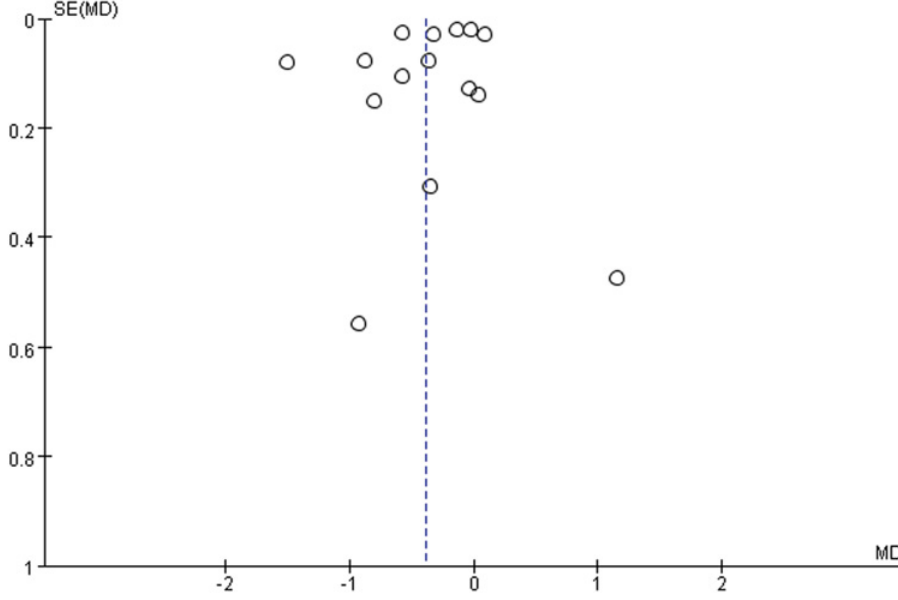
Fig 7. Funnel plot for neointima/media. Blue-dotted line shows the overall estimated mean difference. No obvious evidence for publication bias was found. Abbreviations: MD = mean difference, SE = standard